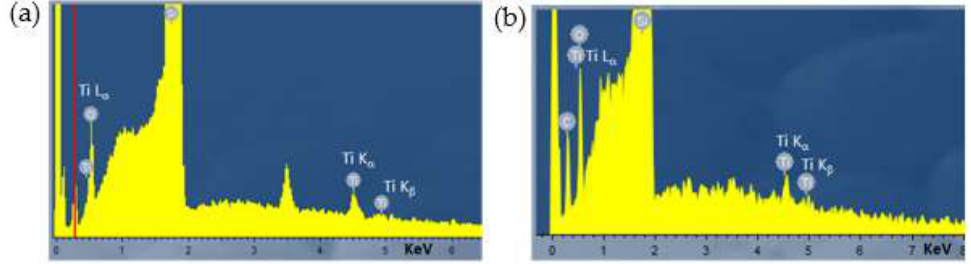
Figure 3. EDX spectra of TiO 2 thin films deposited at pressures of ( a ) 0.17 Pa and ( b ) 0.8 Pa. Table 3. Chemical analysis from